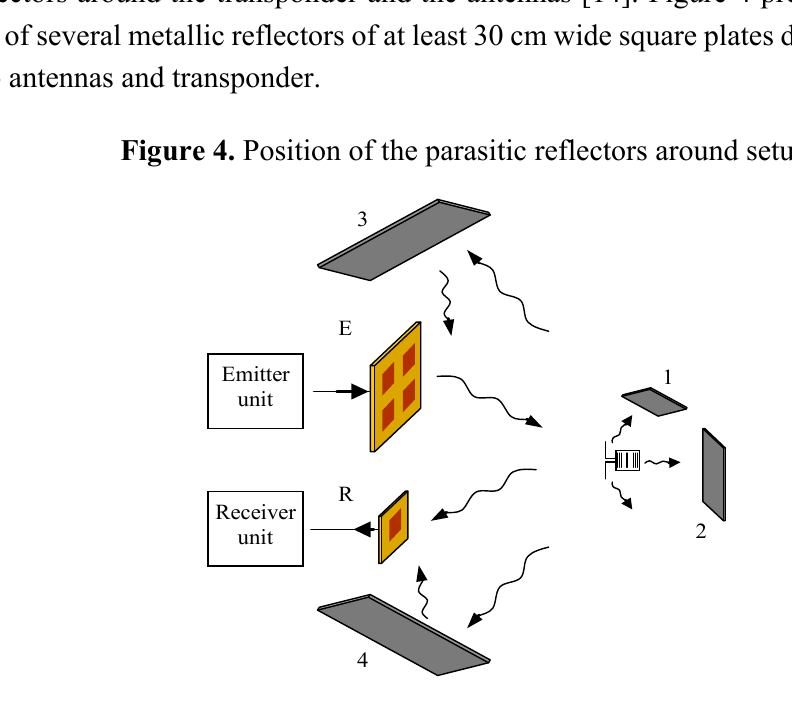
Figure 5. Distance error estimated in complex